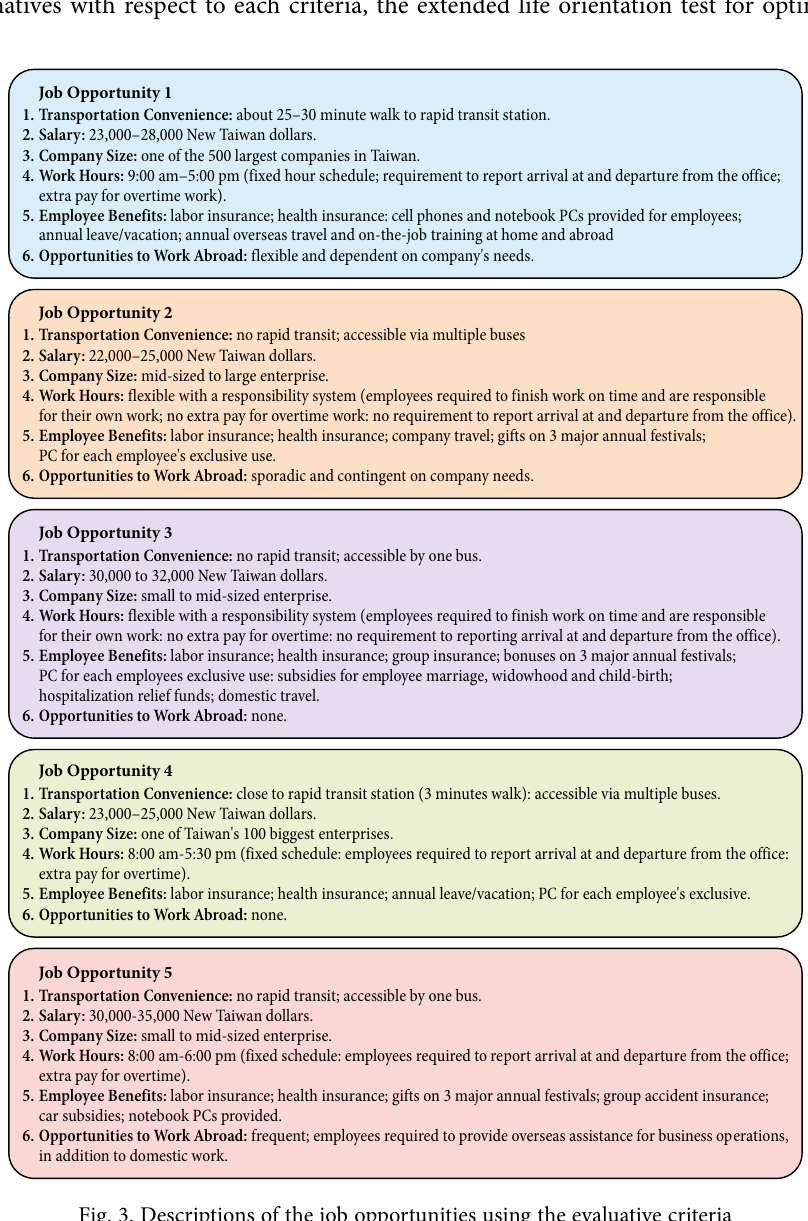
Fig. 3. Descriptions of the job opportunities using the evaluative